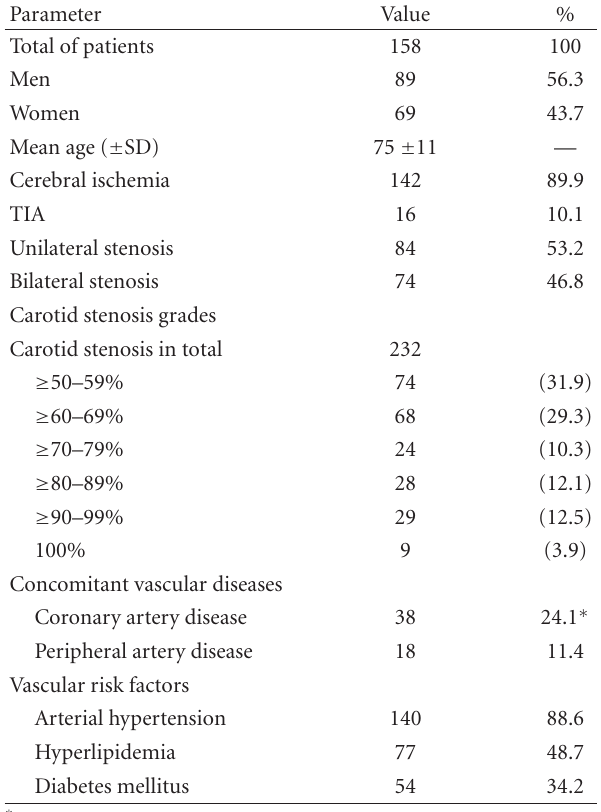
Table 2: Patient